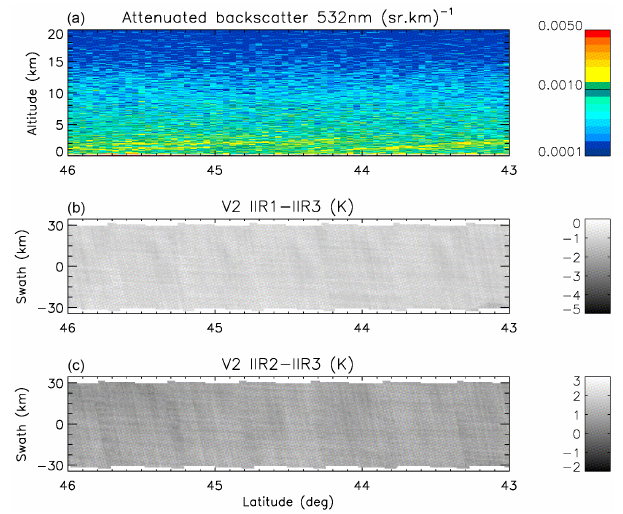
Figure 11. Version 2 IIR inter-channel BTDs in the same nighttime descending portion of the same orbit as in Fig. 3. (a) CALIOP lidar attenuated backscatter; (b) IIR1-IIR3 BTD; (c) IIR2-IIR3 BTD. The striping effect is significantly attenuated compared to Version 1.